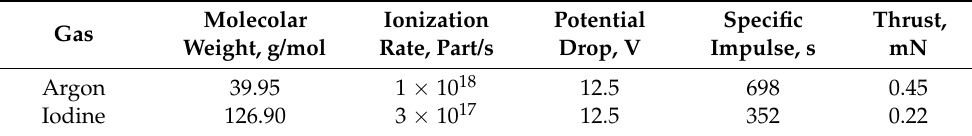
Table 3. Comparison between the thrust performance by using argon and iodine gas at 10 eV, enforcing an ion mass flow rate of 6.5 × 10 − 8 kg/s.